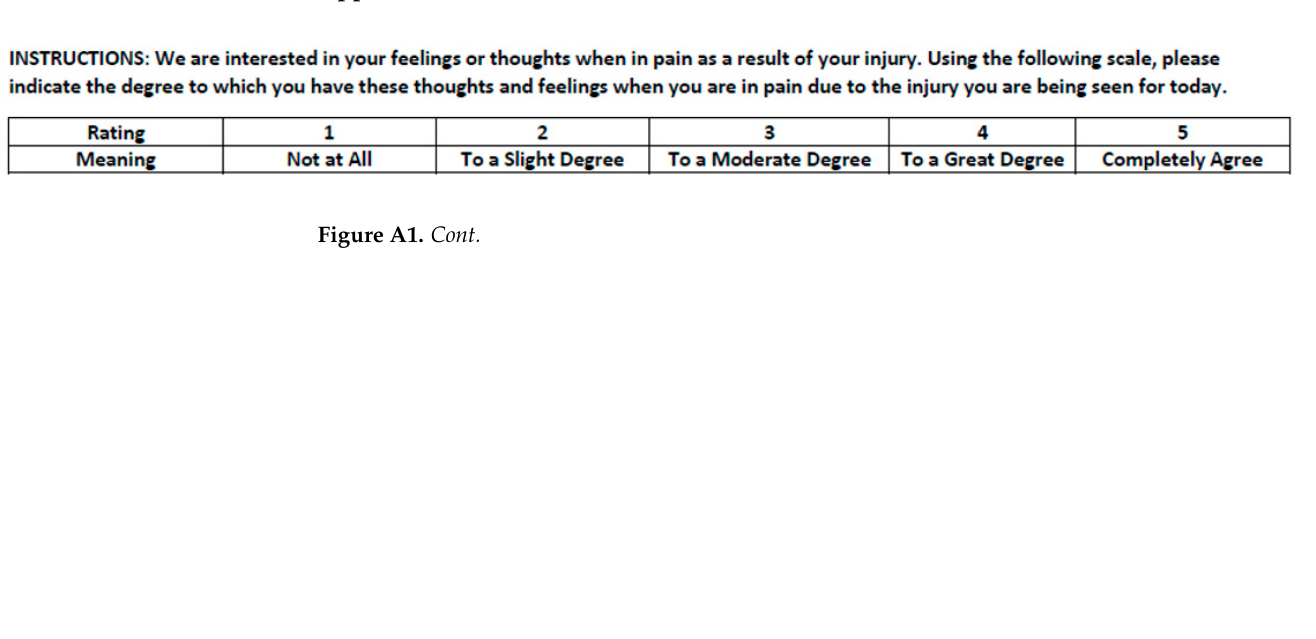
Figure A1. Return to Duty Readiness Questionnaire (RDRQ). References 1.